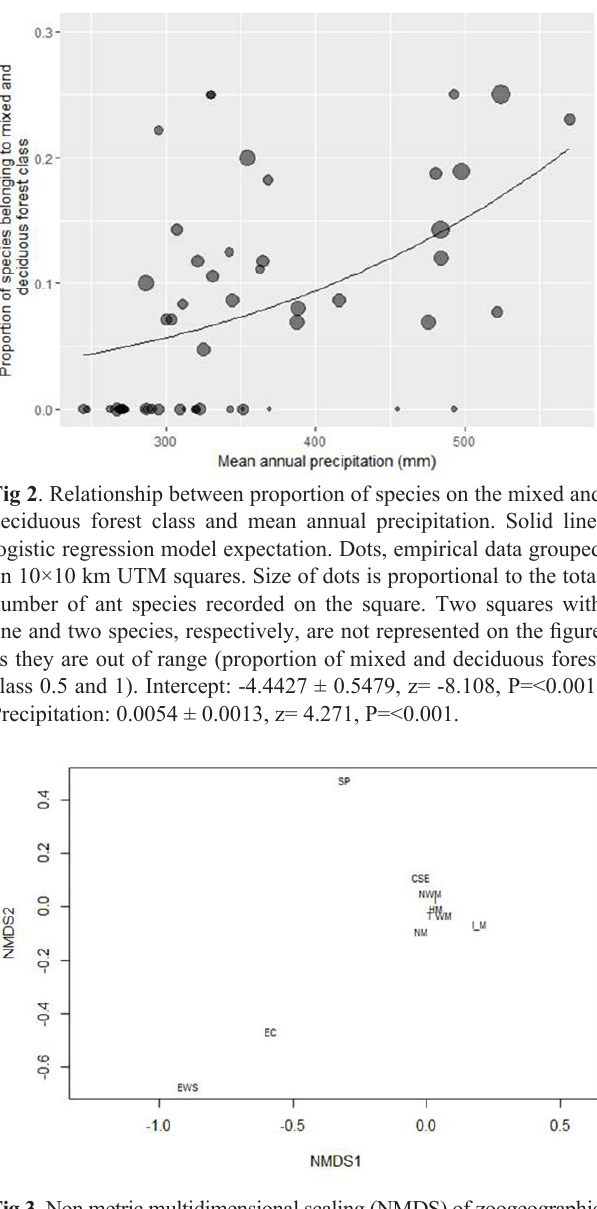
Fig 3 . Non metric multidimensional scaling (NMDS) of zoogeographic elements on 10×10 km UTM squares representing the geological, geomorphological and climatic variation of the Segura River Basin. CSE = Central and Southern European, EC = Euro-Caucasian, EWS = Euro-West Siberian, HM = Holomediterranean, I = Iberian, I/M = Iberian/ Maghrebian, NM= North-Mediterranean, NWM = North- West Mediterranean, SP = South-Paleartic, T = Tethyan, WM = West-Mediterranean.